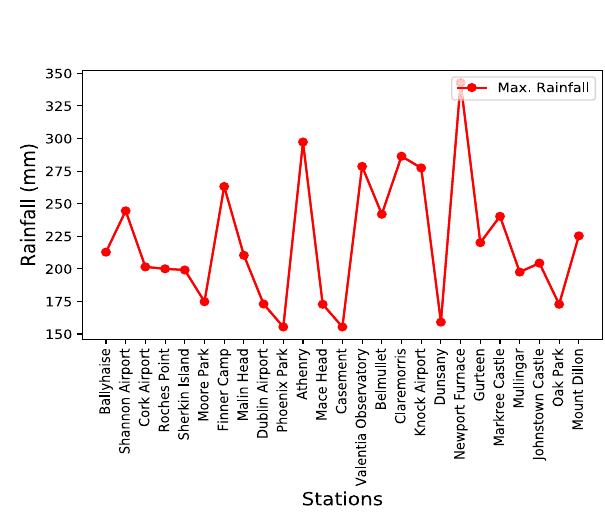
Figure 1: The maximum values of rainfall amounts for all